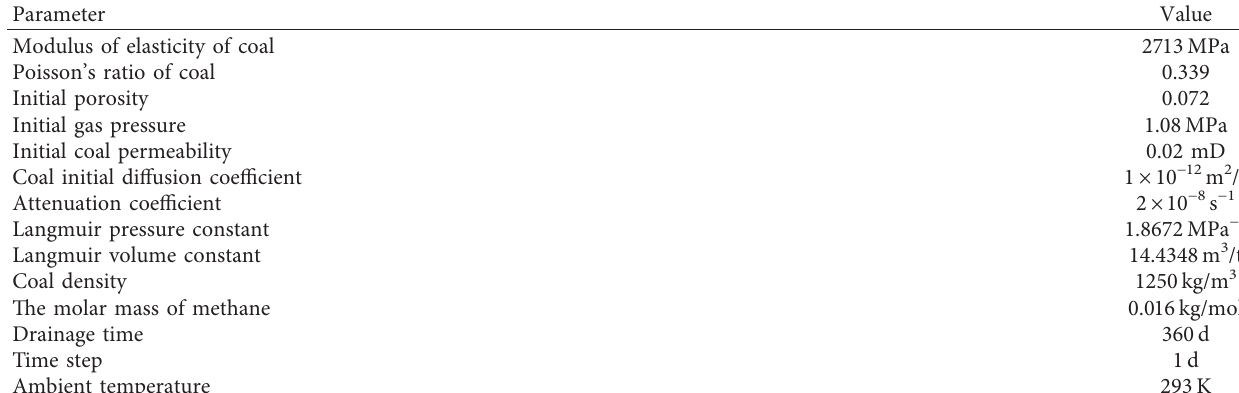
Table 1: Parameters used in numerical simulation [17].